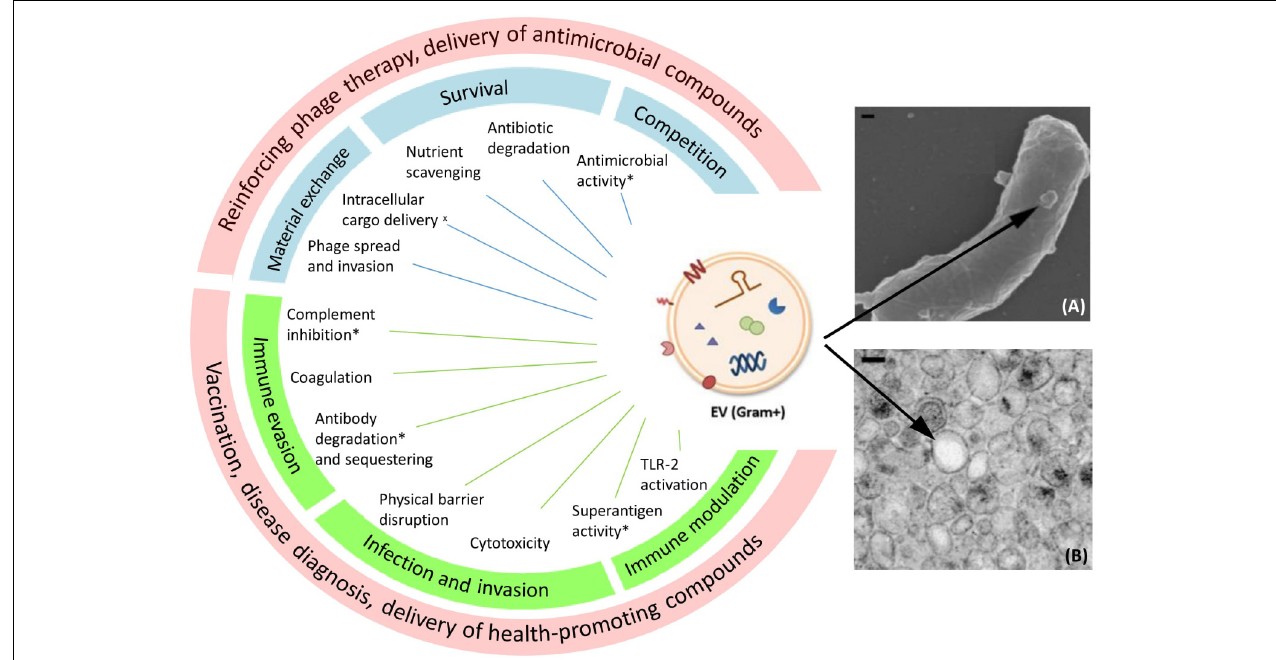
FIGURE 1 | Proposed functions and potential medical applications of Gram-positive EVs. On the left side a schematic drawing of EVs carrying different types of cargo is shown. Functions marked with an asterisk ( ∗ ) have been proposed on the basis of EV protein content, but a functional effect remains to confirmed. ( x ) Bacterial cell–cell communication supported by membrane fusion assays. Blue boxes show EV roles in bacterial physiology and ecology, green boxes show EV roles in microbe–host interaction, and red boxes show proposed applications of EVs. On the right side a SEM picture (A) of EV production from Bacillus subtilis and a TEM picture (B) of isolated B. subtilis EVs are shown as examples (Brown et al., 2014). Copyright 2018 Wiley-Blackwell. EM pictures used with permission. Scale bars: 100